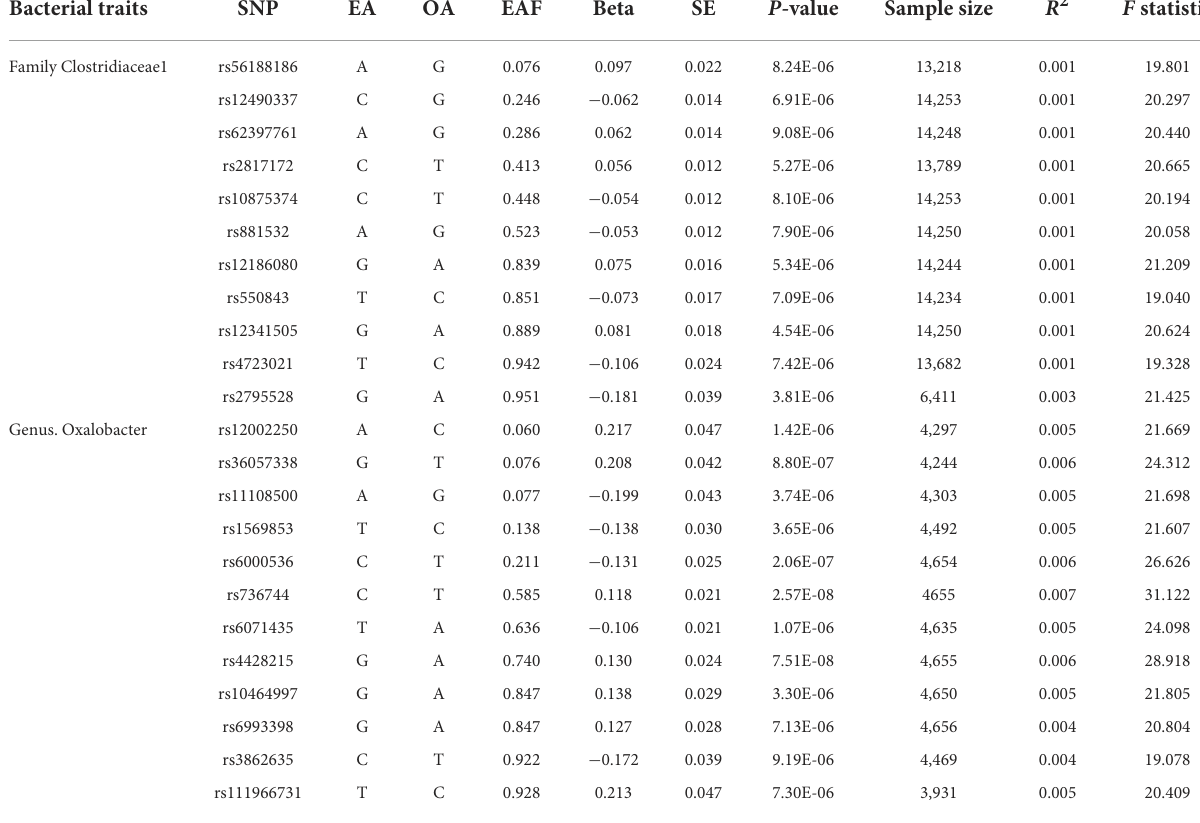
Bacterial traits